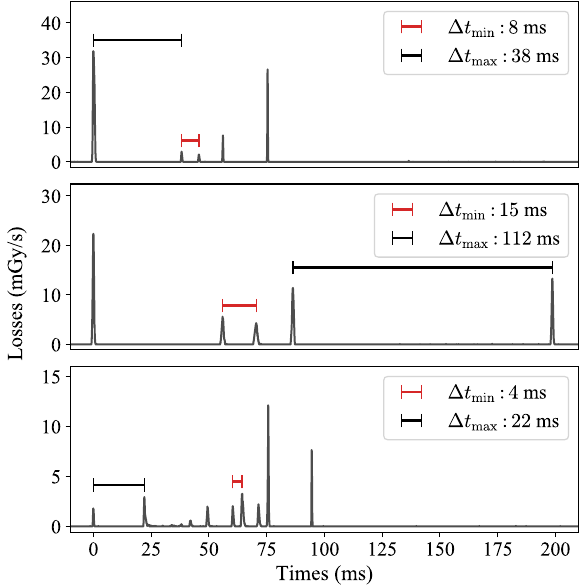
FIG. 13. Measurement of multipeaks beam loss events attrib- uted to dust grains during LHC Run II (2015 – 2018). Given the response factor of the beam loss monitors, the amplitude of the losses is in the order of 10 9 – 10 10 inelastic collisions = s. For each event, the shortest and longest peak separation is identified.